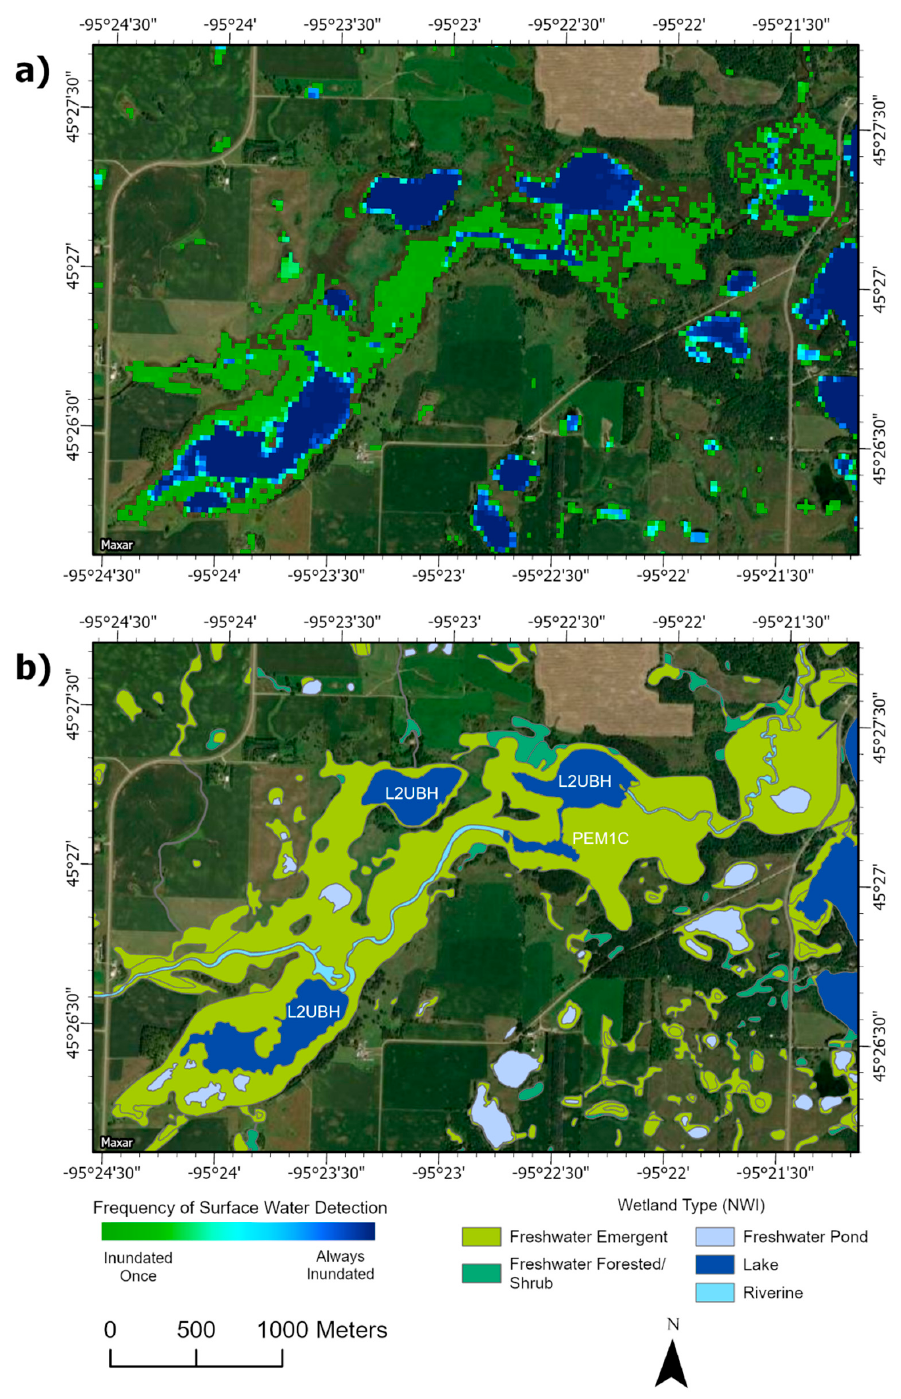
Figure 9. The performance of LandTrendr for emergent wetlands as compared to the National Wetlands Inventory. ( a ) The LandTrendr result for an emergent wetland in western Minnesota, near Swift Falls. ( b ) The National Wetlands Inventory data for the same region. Note that while the persistently inundated deep-water basins in panel b have approximately the correct shape in panel a, the emergent wetlands surrounding them that are only seasonally inundated for short periods (PEM1C Cowardin classification) appear as infrequently inundated in panel a, with individual pixels and larger areas not predicted as inundated at all. There are also very small patches (<5 pixels) that are commission in the LandTrendr output but appear similar in frequency of inundation to emergent